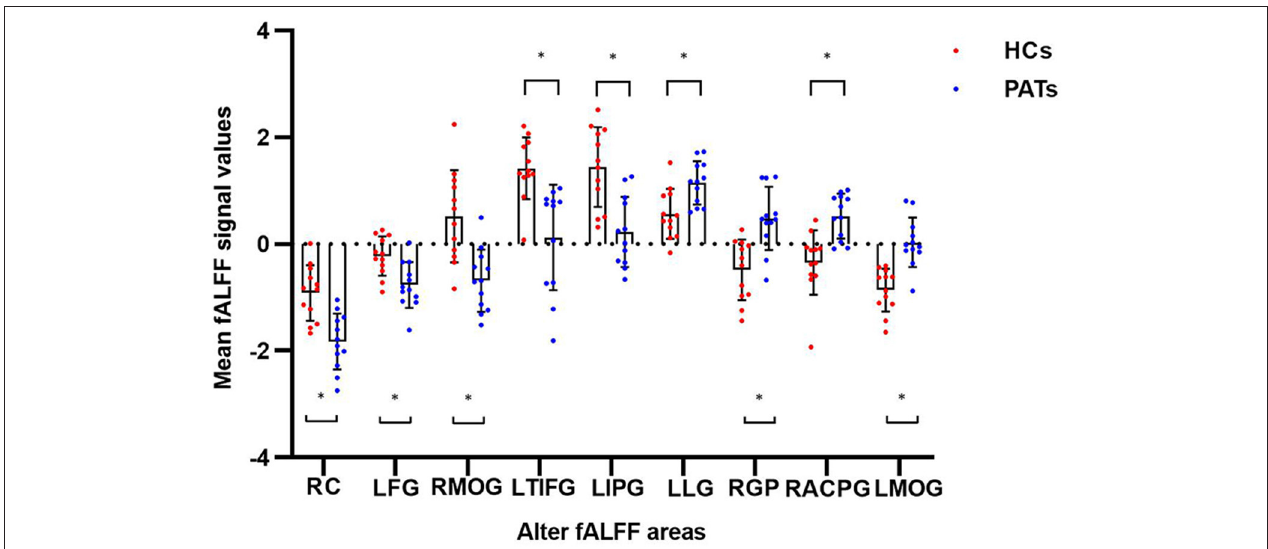
FIGURE 3 | The mean fALFF values between the PATs group and HCs. Means of altered spontaneous brain activity between the PATs group and HCs group (each n = 12). Compared with HCs, asterisk means the statistical significance p < 0.05. RC, right cerebellum; LFG, left fusiform gyrus; RMOG, right medial orbitofrontal gyrus; LTIFG, left triangle inferior frontal gyrus; LIPG, left inferior parietal gyrus; LLG, left lingual gyrus; RGP, right globus pallidum; RACPG, right anterior cingulate and paracingulate gyri; LMOG, left middle occipital gyrus; fALFF, fractional amplitude of low-frequency fluctuations; HCs, healthy controls; PATs, MGD patients in SO population.